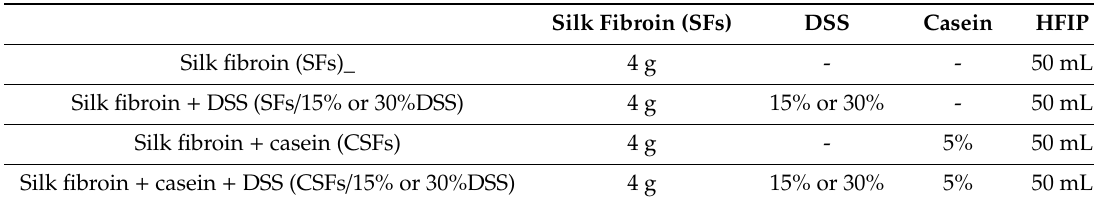
Table 1. Content of solutions prepared for